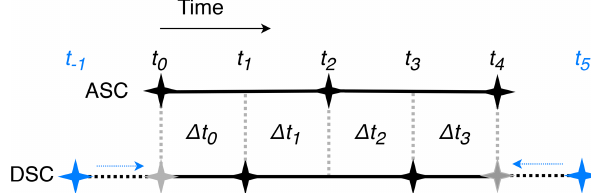
Figure 1. Schematics of the simplified case described by Eq. (3). Ascending and descending SAR acquisitions at time t i are marked with black stars. Horizontal solid lines represent range and azimuth offset maps. Vertical dashed lines divide temporal scale in time in- tervals (cid:49)t i = t i + 1 − t i between consecutive acquisitions. The times of first and last descending acquisitions (marked with blue stars) are adjusted to match the first and last time of ascending acquisitions (marked with gray